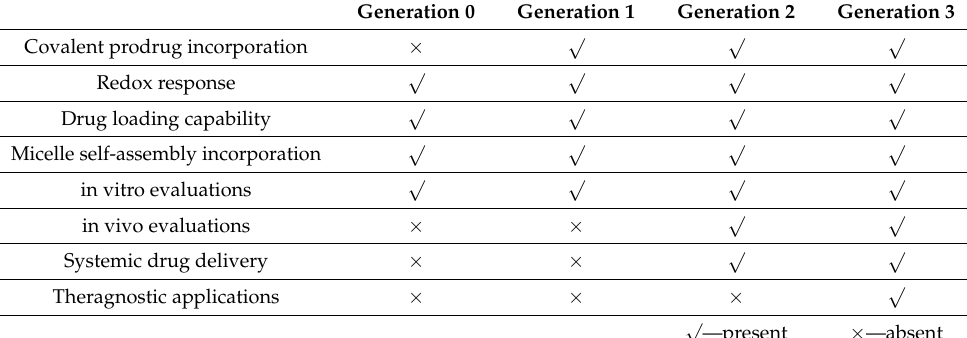
Table 1. Polyoxalate, oxalate, and copolyoxalate-based formulations